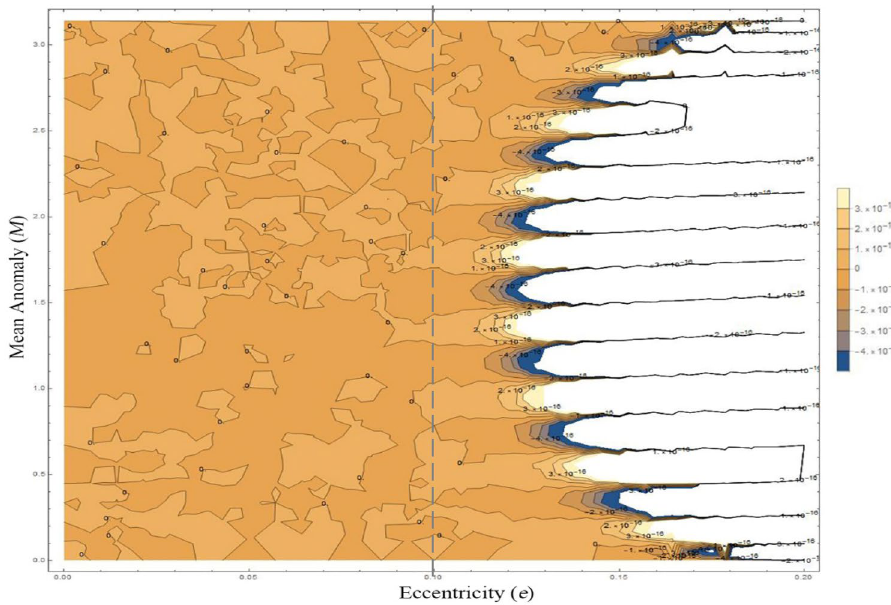
E true − f ( E true − e sin E true ) (cid:31) (cid:31)